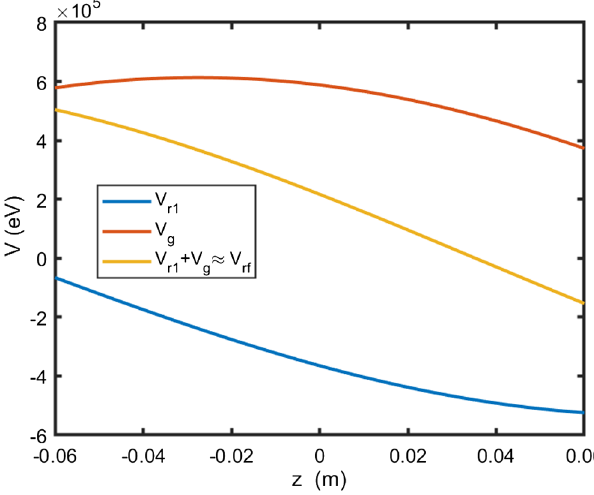
FIG. 1. Charge density for complete fill at 500 mA, with compensated main cavity (blue) and without main cavity (red). FIG. 2. MC induced voltage V r 1 , generator voltage V g and their sum.